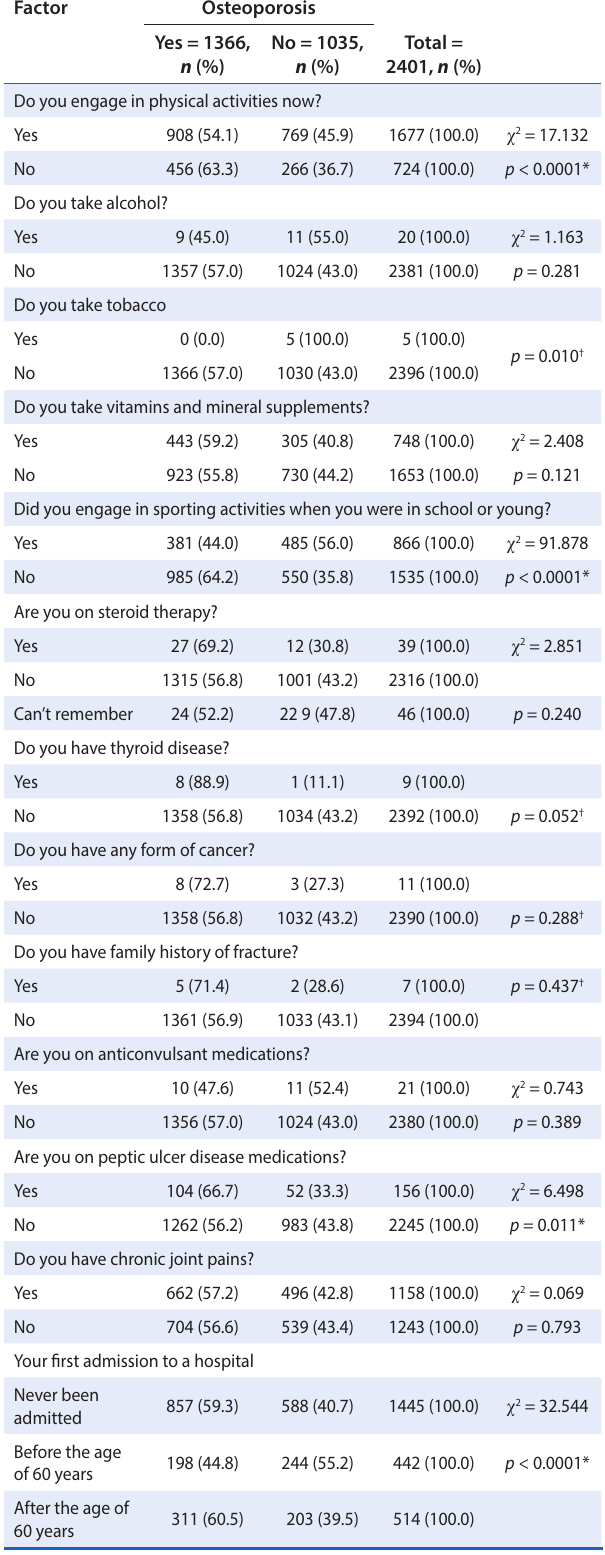
*Significant at 5% level of significance. † Fisher’s exact